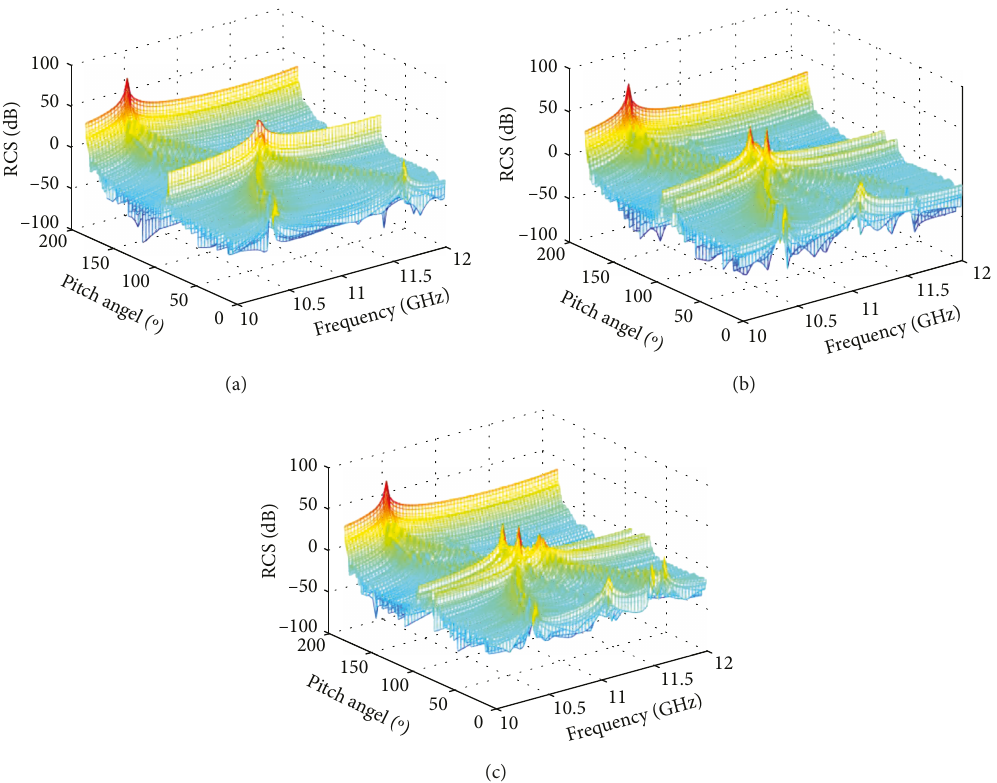
Figure 4: 3-dimensional e ff ect pictures of RCS of the three types of targets: (a) cone target; (b) cone-cylinder target; (c) cone-cylinder- fl are target.